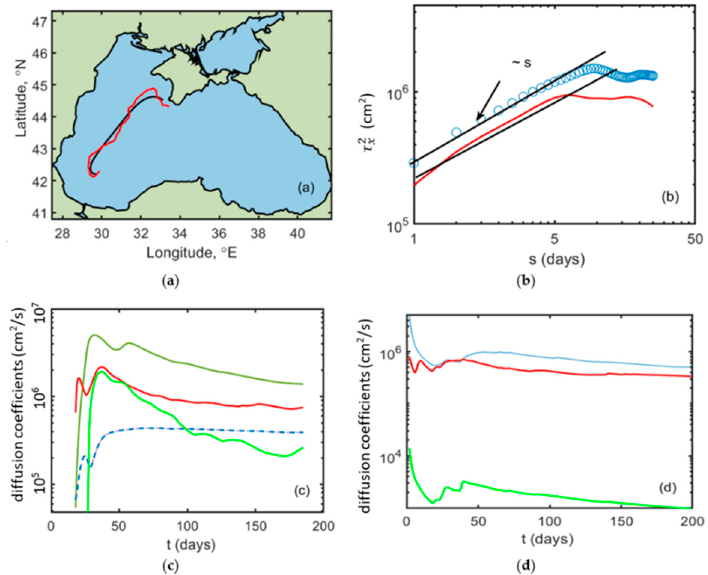
Figure 5. Time dependence of the second moments of time-averaged mean square displacements and turbulent diffusion coefficients for drifter #16330: ( a ) original (red) and mean Lagrangian (black)